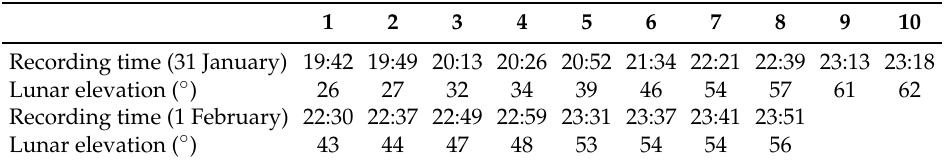
Table 2. Parameters of the measurement at Local Time